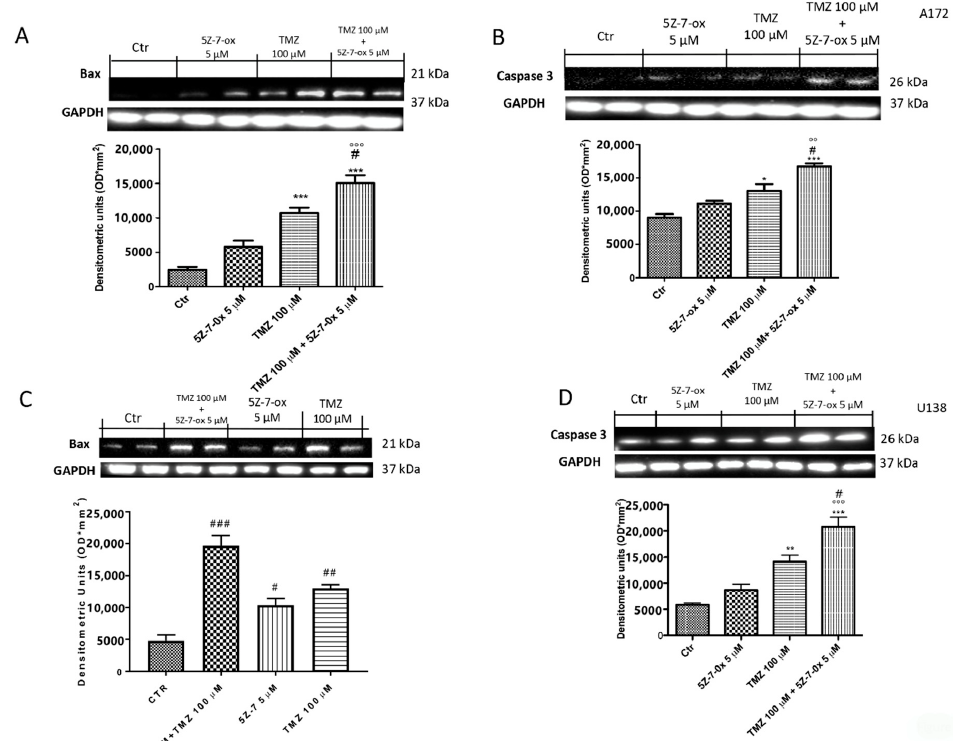
Figure 2. Effect of 5Z-7-ox and TMZ on Bax and Caspase 3 expression in glioblastoma cells. The association between 5Z-7-ox and TMZ decrease significantly increased the expression of Bax and caspase 3 in A172 and U138 cell lines ( A – D, respectively). ( A ) *** p < 0.001 vs. CTR; # p < 0.001 vs. TMZ and °°° p < 0.001 vs. 5Z-7-ox; ( B ) * p < 0.001 vs. CTR, *** p < 0.05 vs. CTR., # p < 0.001 vs. TMZ and °° p < 0.01 vs. 5Z-7-ox. The association of 5Z-7-ox with TMZ significantly modulated their expression much more of single components ( A – D, respectively). Data are representative of at least three independent experiments. ( C ) # p < 0.001 vs. CTR, ### p < 0.001 vs. CTR, ## p < 0.01 vs. CTR; ( D ) ** p < 0.01 vs. CTR, *** p < 0.001 vs. CTR, # p < 0.05 vs. TMZ and °°° p < 0.001 vs. 5Z-7-ox. Original blots are shown in Figures S1, S2.